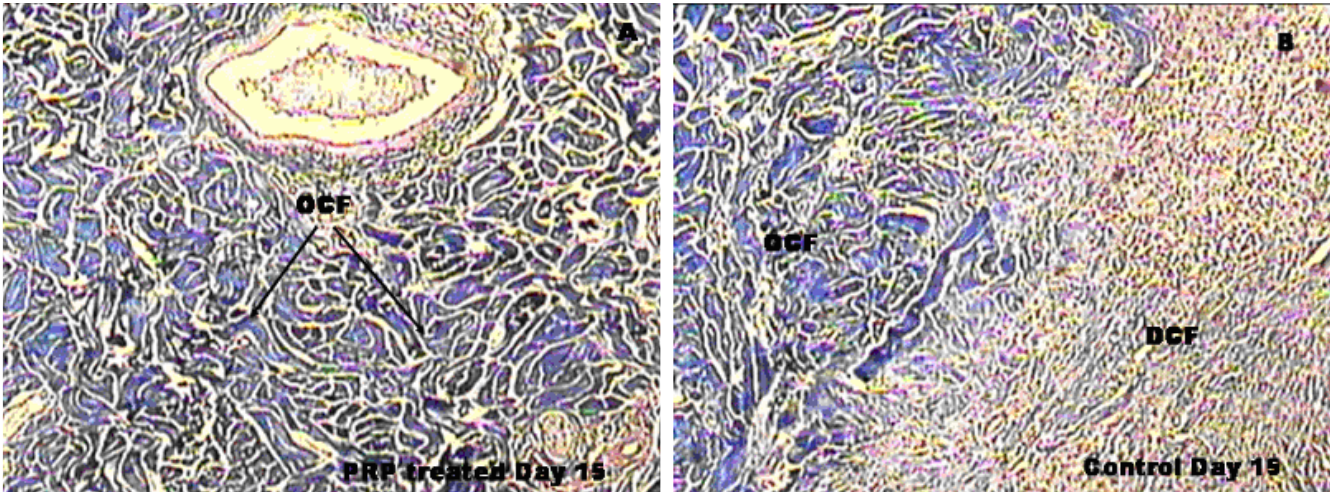
FIGURE 6 - Healing tissues stained with Masson’s trichrome. ( A ) Histological aspect of skin of the PRP Group at Day 15, showing the dermis with connective tissue with organized collagen fibrils (OCF). ( B ) Control Group at Day 15, showing the dermis with connective tissue with organized collagen fibrils (OCF) and disorganized collagen fibrils (DCF). 5 x magnifications